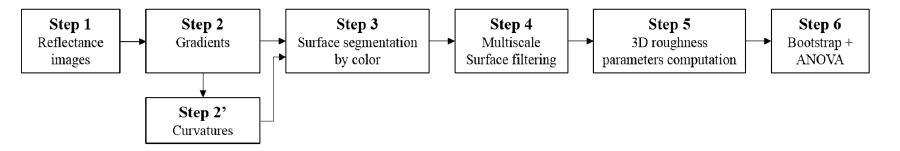
Figure 8. Data treatment.